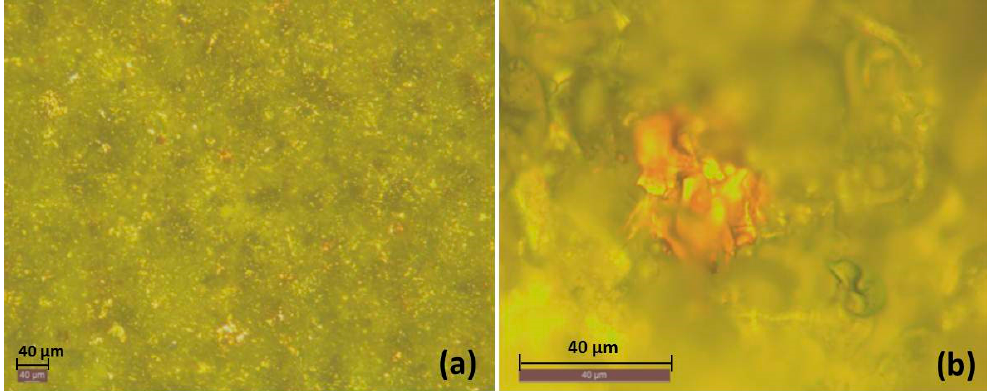
Figure 18. Optical images of PSC coating surface after 10 days of immersion in 3.5% NaCl solution ( a ) low magnification, ( b ) higher low magnification, ( b ) higher magnification.